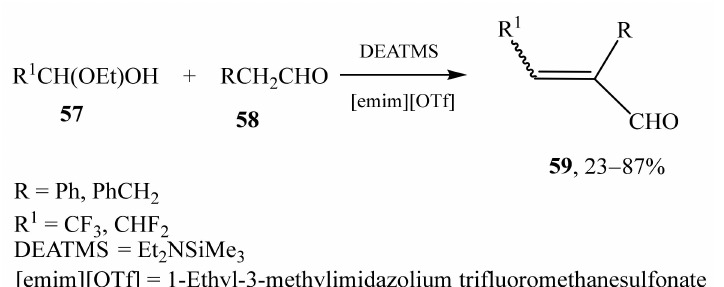
Scheme 23. Synthesis of 3-fluoromethyl-2-substituted propenals 59